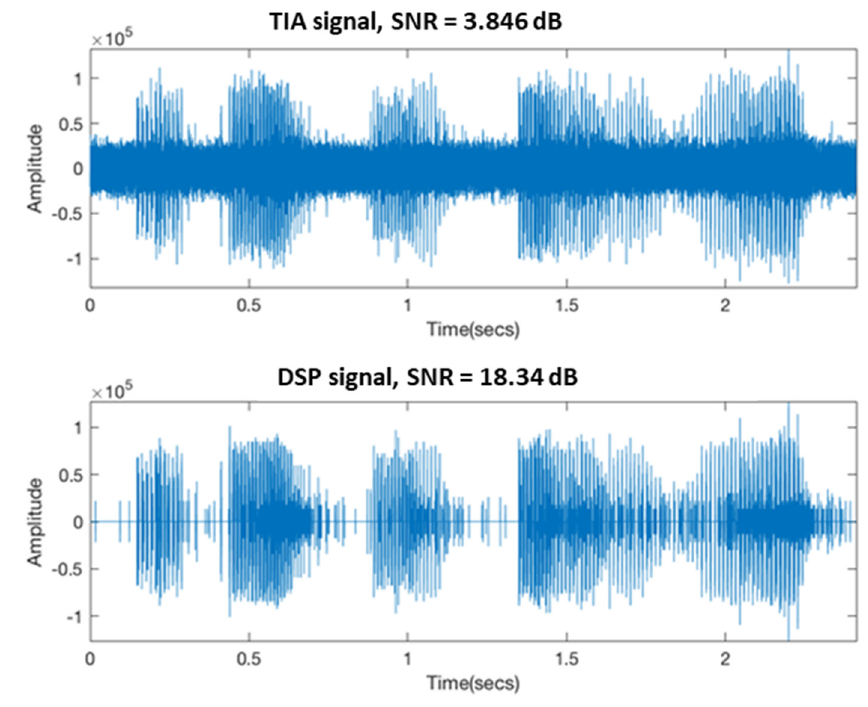
Figure 17. Time − domain signal of TIA and DSP output.